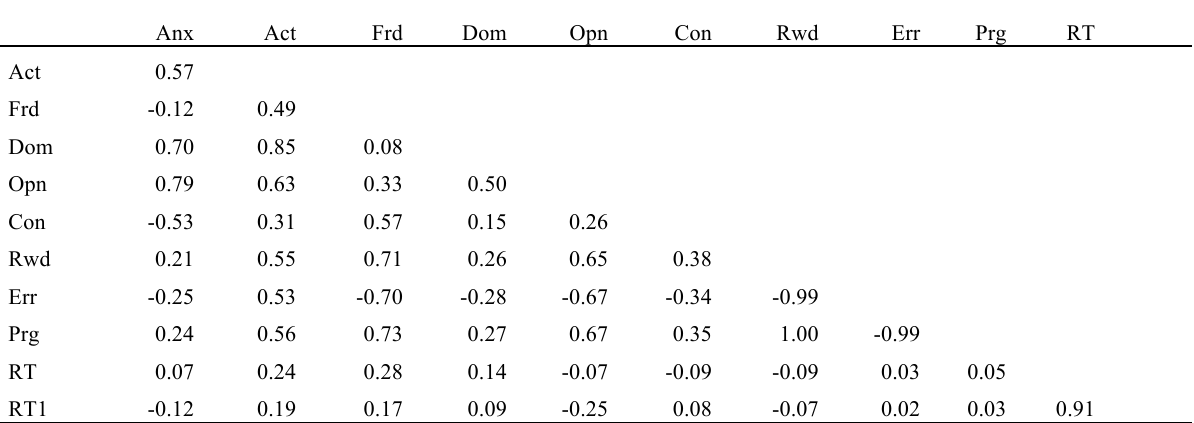
Correlations among Personality and Averaged Performance